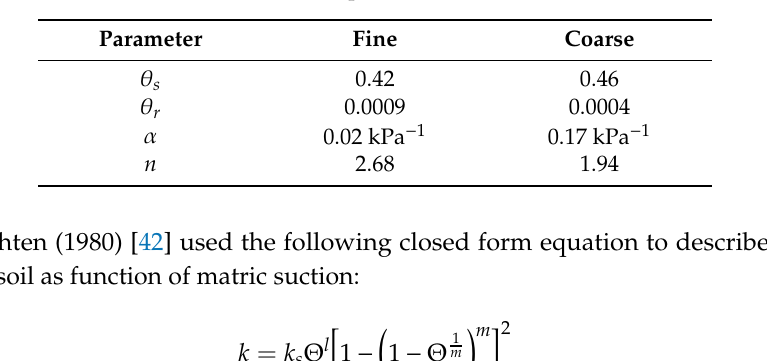
Table 1. van Genuchten (1980) [42] parameters for fine and coarse